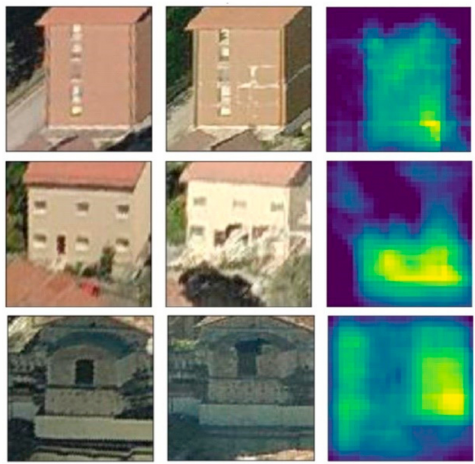
Figure 6. Examples of building damage detection via CNN activation layers, using aerial pre- and post-earthquake façade images. Bright activation colors show damage hotspots (adapted from